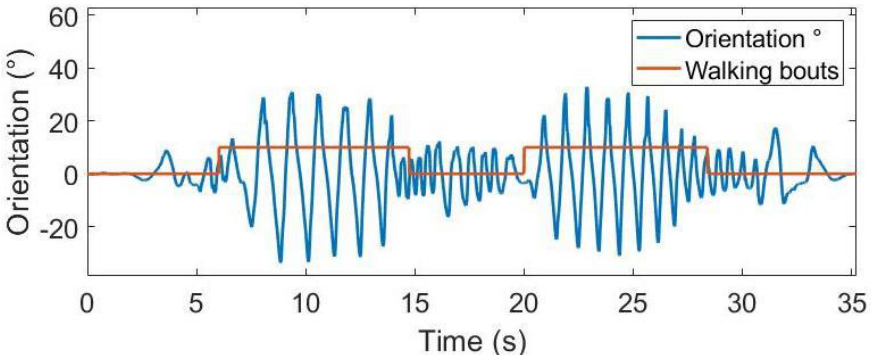
Figure 4. Orientation signal (blue) and walking bouts detected by the algorithm